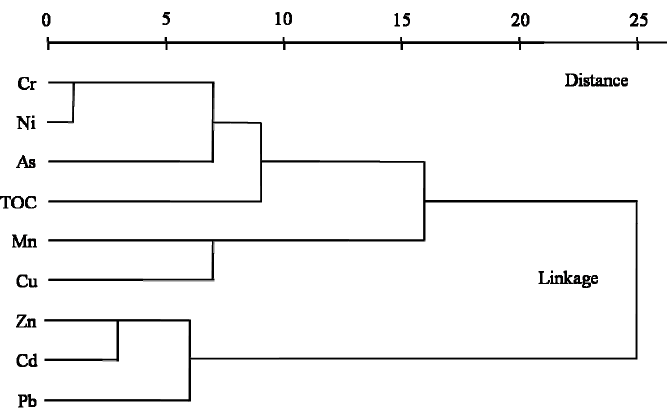
Figure 3. 3-D PCA loading plot for 8 HMs and TOC.